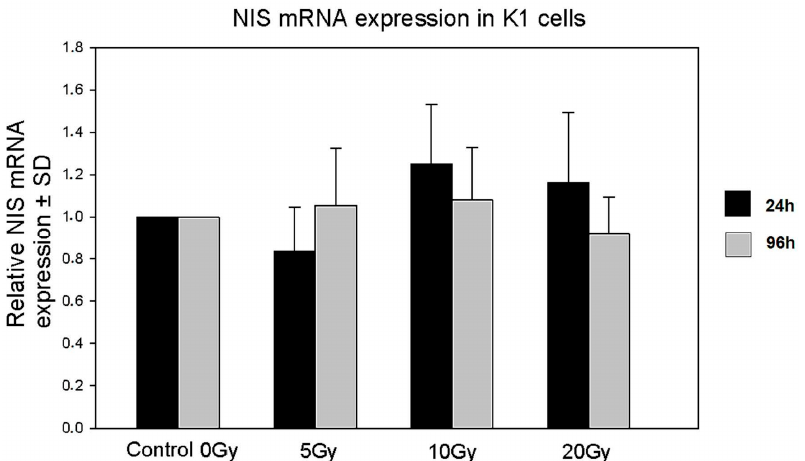
Figure 3. Expression of the NIS gene by K1 cells in culture with 131 I. The graph shows relative NIS gene expression (±SD) in K1 cells directly after 24 h of 131 I exposure (5, 10, 20 Gy) or after additional 72 h of culture without 131 I.